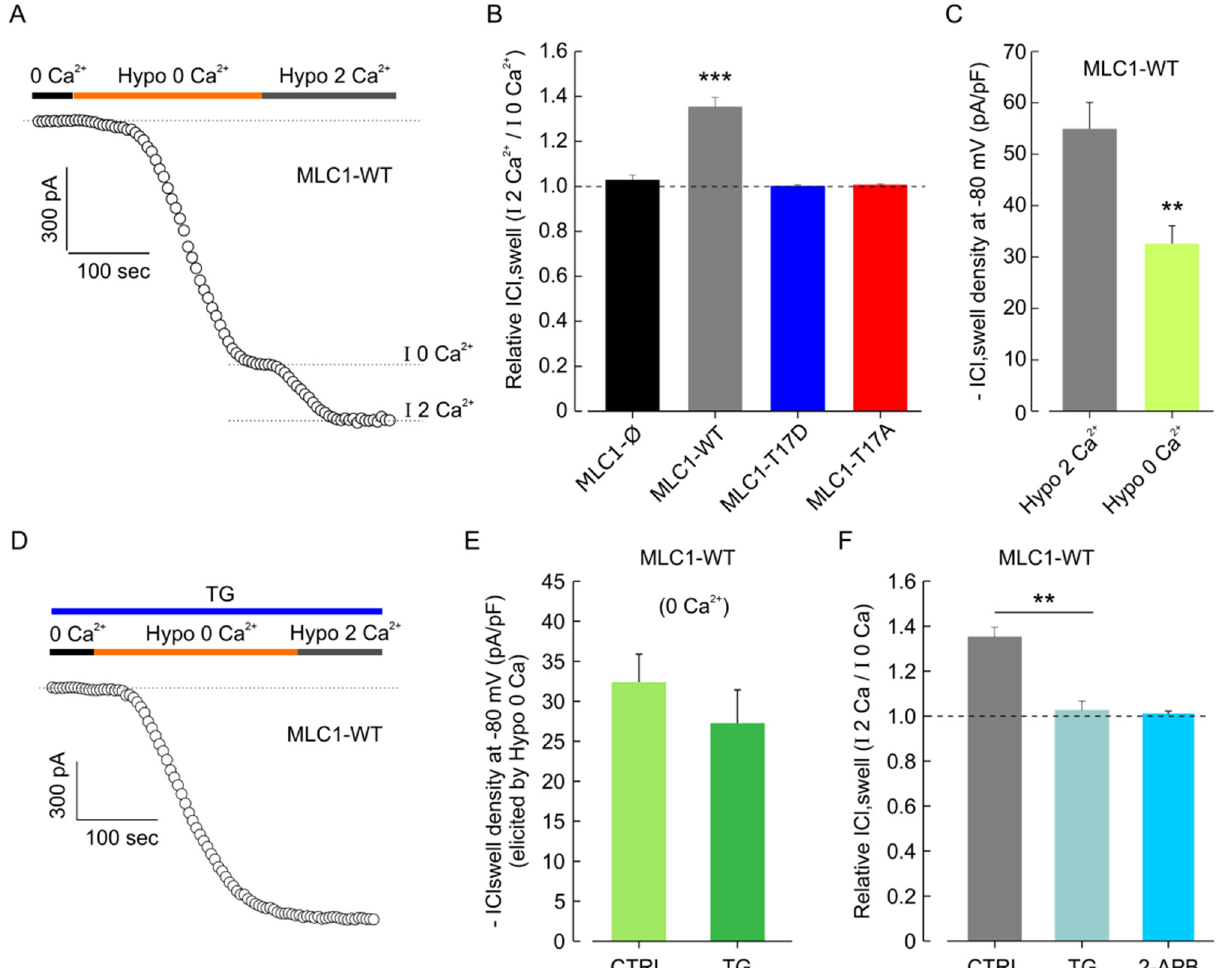
Figure 7. Extracellular and endoplasmic reticulum Ca 2+ -dependence of ICl, swell in U251 cell lines carrying WT and mutated MLC1. ( A ) Representative time course of ICl, swell during application of a Ca 2+ -free hypotonic solution (Hypo 0 Ca 2+ ) and a hypotonic solution containing 2 mM Ca 2+ (Hypo 2 Ca 2+ ). The dashed lines indicate the levels where the maximal hypotonic-activated current in the absence (I 0 Ca 2+ ) and presence (I 2 Ca 2+ ) of extracellular Ca 2+ were measured. ( B ) Bar plot showing the mean ICl, swell current elicited by the addition of 2 mM external Ca 2+ (dashed lines), normalized to the current activated by Hypo 0 Ca 2+ , in MLC1-Ø ( n = 5), MLC1-WT ( n = 8), MLC1-T17D ( n = 6), and MLC1-T17A ( n = 5) U251 cell lines (mean ± SEM, *** p < 0.01, using one-sample t -test). ( C ) Bar plot showing the average current density during exposure to hypotonic solution, in the continuous presence (grey bar, n = 14) or absence (light green bar, n = 9) of external Ca 2+ , assessed in MLC1-WT cells (mean ± SEM, ** p < 0.01, using two-sample t -test). ( D ) Representative time course of ICl, swell during application of a Ca 2+ -free hypotonic solution (Hypo 0 Ca 2+ ) followed by a hypotonic solution containing 2 mM Ca2+ (Hypo 2 Ca 2+ ), after 1 µM of thapsigargin (TG) pretreatment (5 min to deplete ER Ca 2+ stores). ( E ) Bar plot showing the average current density during exposure to hypotonic 0 Ca 2+ solution, in MLC1-WT cells in the absence (CTRL, n = 9) and presence (TG, n = 9) of TG pre- treatment (mean ± SEM, p = 0.36). ( F ) Bar plot showing the mean fractional ICl, swell elicited by Hypo 2 Ca 2+ , normalized to the current activated by Hypo 0 Ca 2+ , in MLC1-WT cells either in the absence ( n = 14) or presence ( n = 9) of TG or of the IP3R inhibitor 2-APB ( n = 7) (mean ± SEM,** p < 0.01).